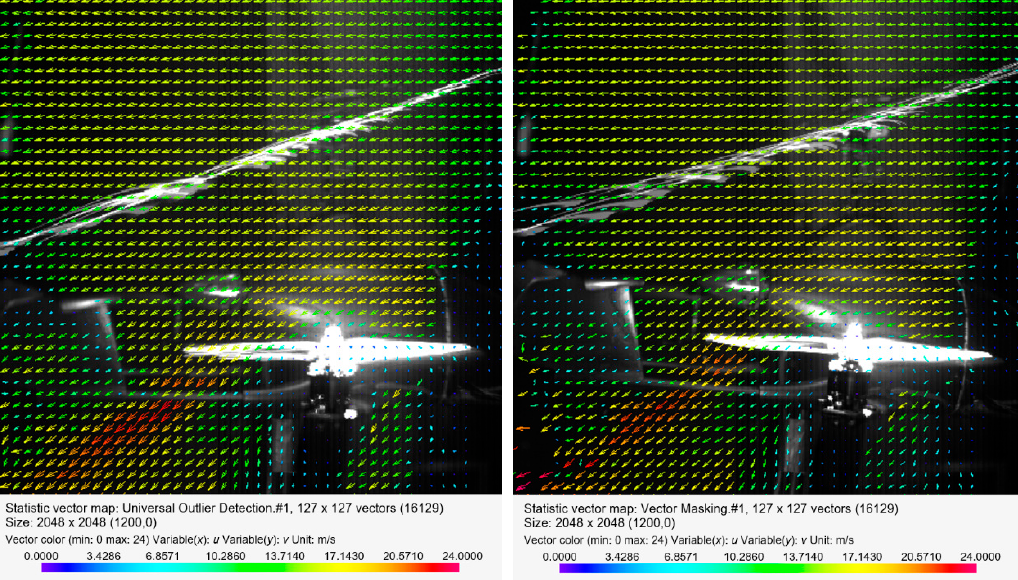
Figure 14. Velocity field around the horizontal propeller for the following configuration: angle of attack α = − 4° (on the left) and angle of attack α = − 8° (on the right), with an airflow velocity of v wt = 12.5 m/s.